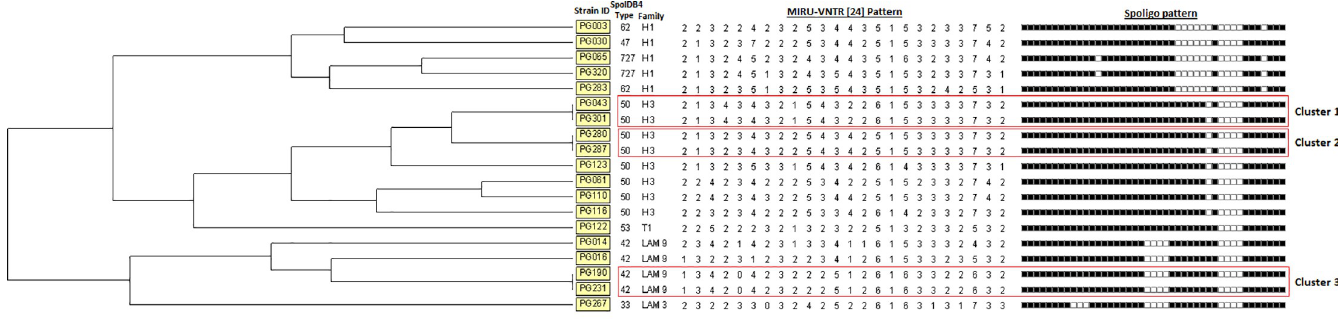
Fig 2. Results obtained, including genotyping information by spoligotyping and 24-loci MIRU. UPGMA-Tree, MIRUS-VNTR[24]: categorical (1), Spoligo: Categorical (1) � Clusters are labeled in red boxes.